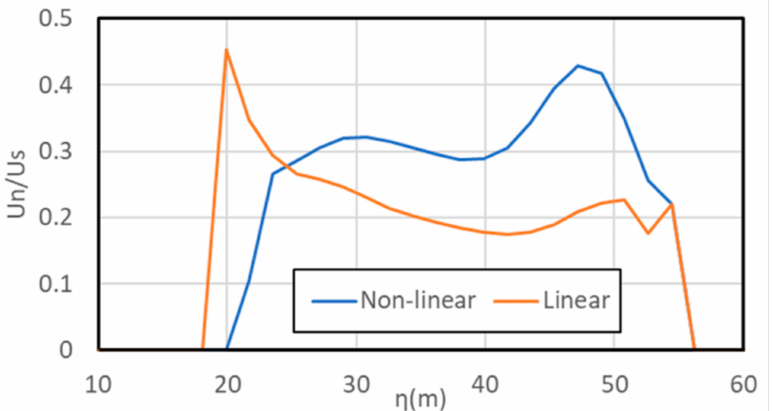
Figure 13. Profiles of Un/Us along the A-A’ section in the results of different turbulence models. “Nonlinear”: nonlinear k- ε model (Run 3); “linear”: linear standard k- ε model (Run 6); Us: flow in the channel direction near the bottom; Un: lateral flow toward the inner bank near the